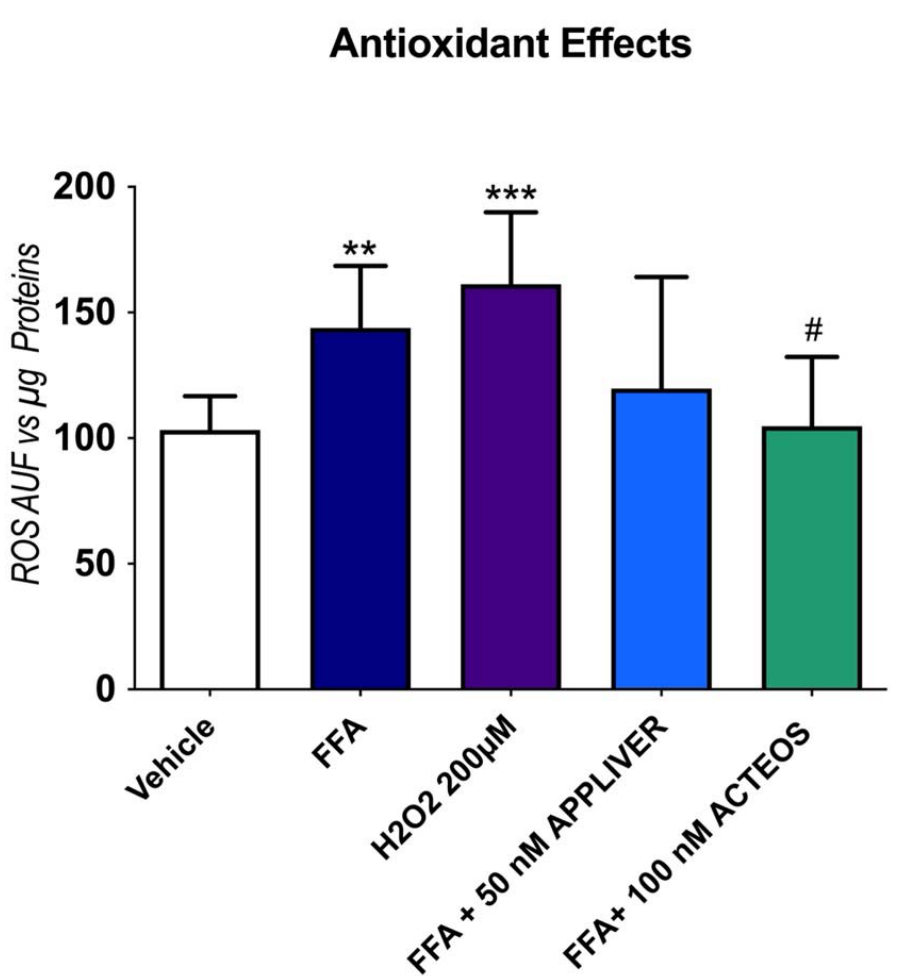
Figure 5. Assessment of antioxidant properties of APPLIVER and ACTEOS induced by FFA. Fluorescence was normalized by the total proteins present in the cell lysates ( µ g) assessed using fluorescamine assay. Values presented are the mean ± SD of three independent experiments. ** p < 0.01 vs. vehicle, *** p < 0.001 vs. vehicle, # p < 0.05 vs. FFA. Abbreviations: AUF, arbitrary unit of fluorescence; FFA, free fatty acids; H 2 O 2 , hydrogen peroxide.